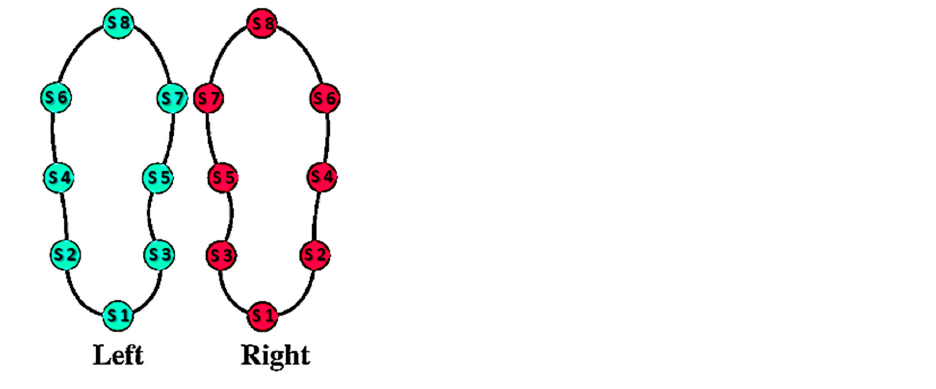
Figure 2. Force-sensitive insole. Each insole placed in subjects’ shoes contains eight pressure-sensitive sensors in order to record the time series of the ground reaction force (GRF), while subjects were asked to walk on level ground.